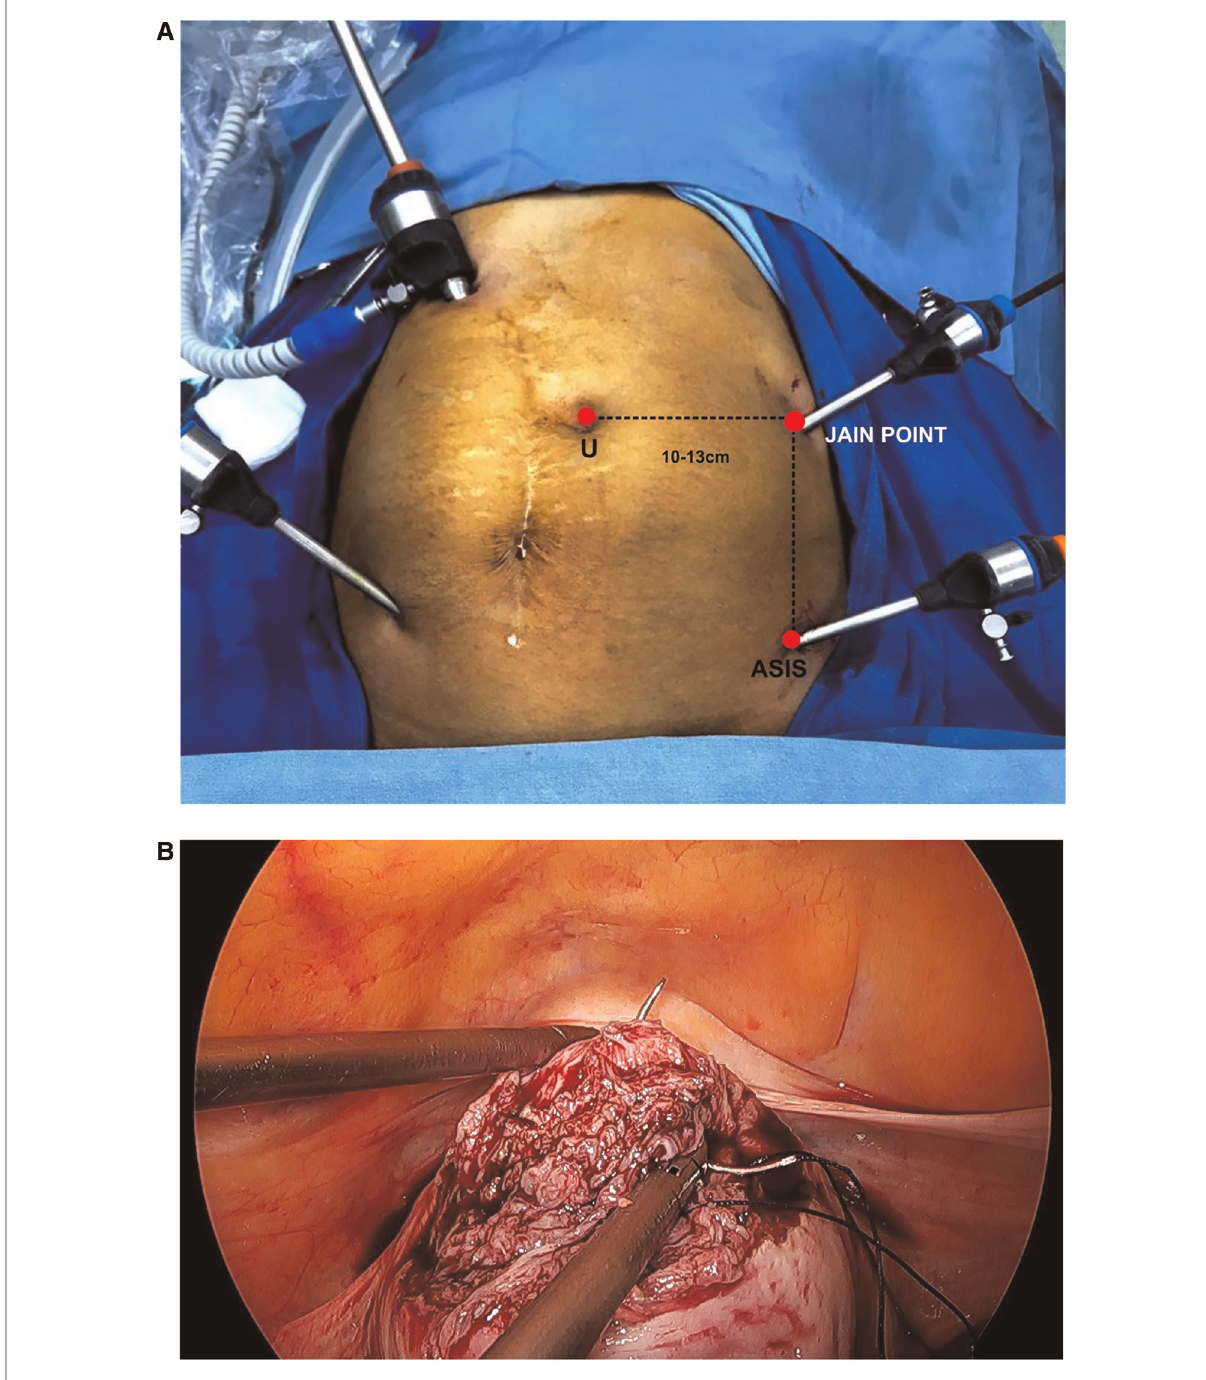
Table 2 shows the distribution pattern of the 2,519 patients with previous surgery, according to their BMI, which ranged from <18.5 to ≥ 40 kg/m 2 . Our study reveals that overall, in patients with a history of previous surgery, we operated on